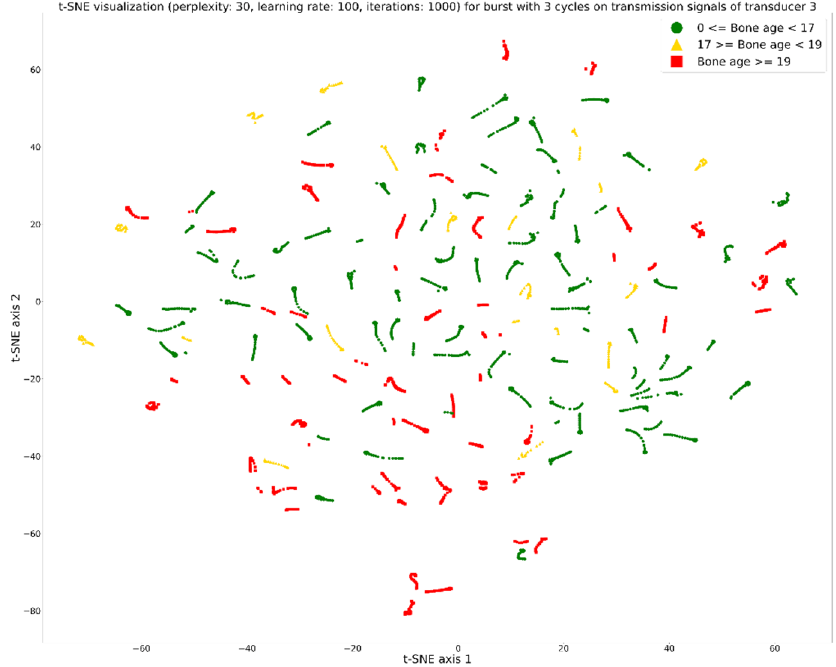
Figure 11. Two ‐ dimensional t ‐ SNE visualization showing the interrelation of all A ‐ scans. Color Figure 11. Two-dimensional t-SNE visualization showing the interrelation of all A-scans. Color codes codes for bone age groups: green = < 17 years, yellow = 17 to <19 years, and red = ≥ 19 years. for bone age groups: green ≤ 17 years, yellow = 17 to <19 years, and red ≥ 19 years. Appl. Sci. 2022 , 12 , x FOR PEER REVIEW